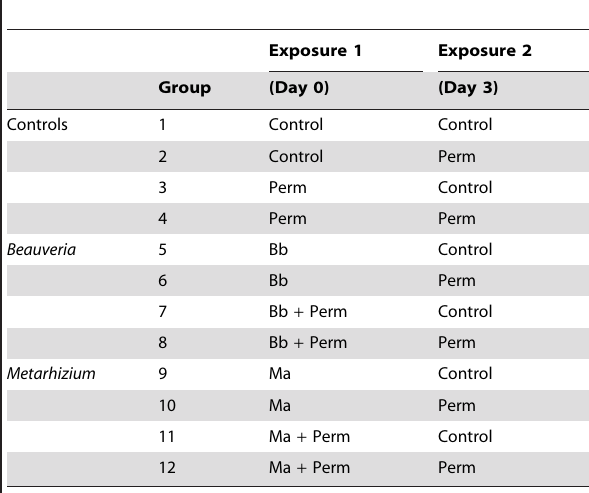
Table 1. Overview of insecticide and fungus exposure